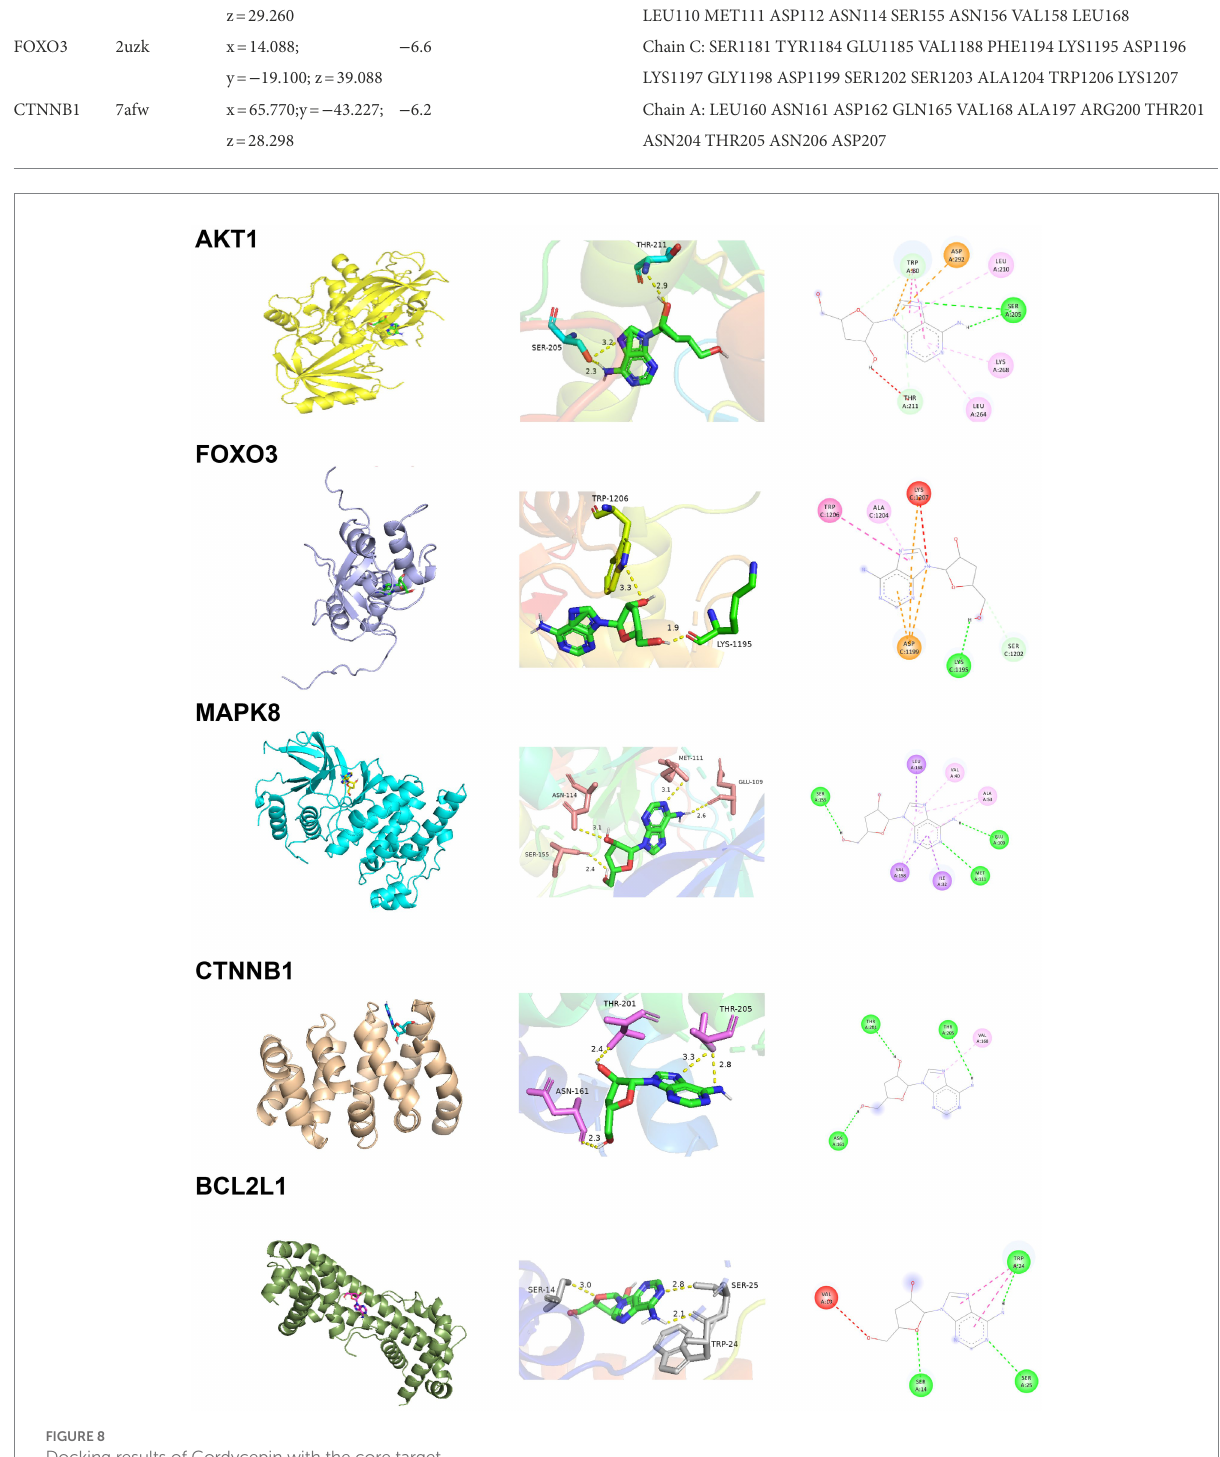
FIGURE 8 Docking results of Cordycepin with the core